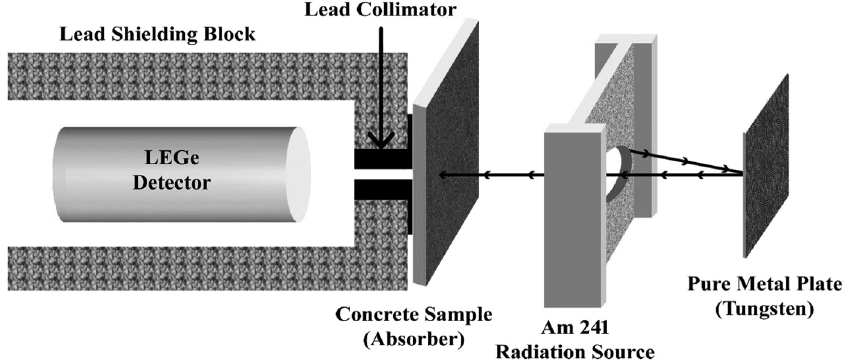
Figure 4: Schematic of the narrow - beam geometry experiment ( X - ray experiment ) .